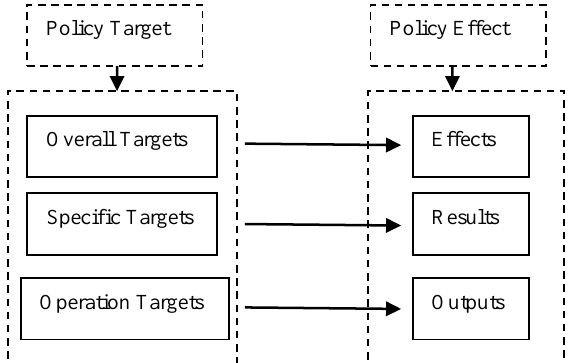
Figure 2The theoretical framework of policy effect evaluation